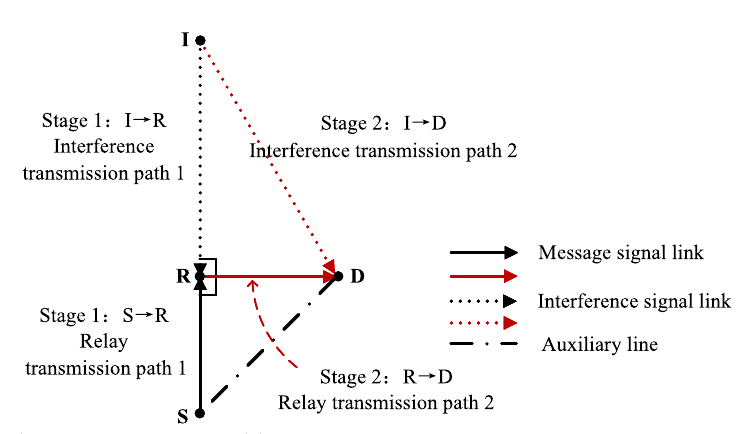
Fig. 6 Relay transmission system